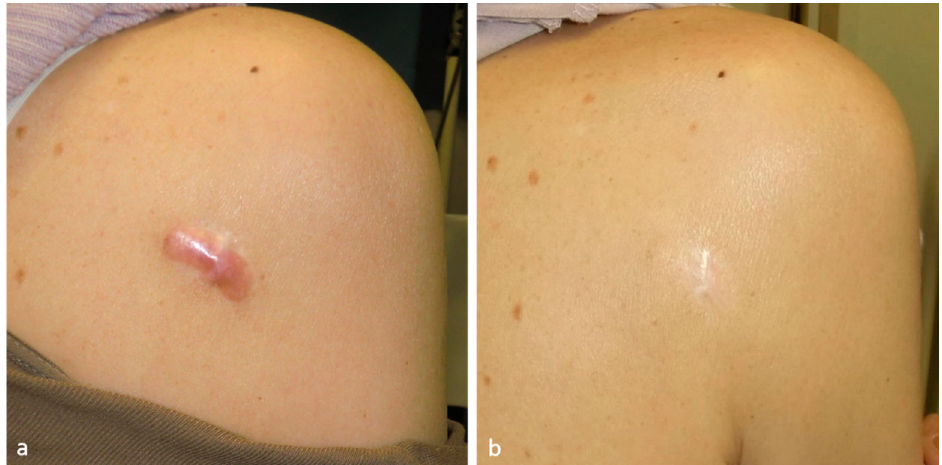
Figure 3. This 75-year-old female had a mild right scapular keloid that was treated by deprodone propionate tape (Eclar ® plaster). The tape was placed on the keloid 24 h a day and was changed daily. The inflammation resolved completely. After 19 months of treatment, both the subjective and objective symptoms of the patient had improved dramatically. ( a ) Pretreatment view; and ( b ) after 19 months of treatment.